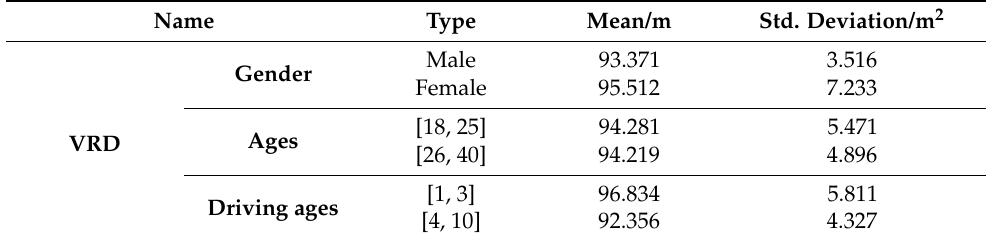
Table 7. The VRD’s descriptive